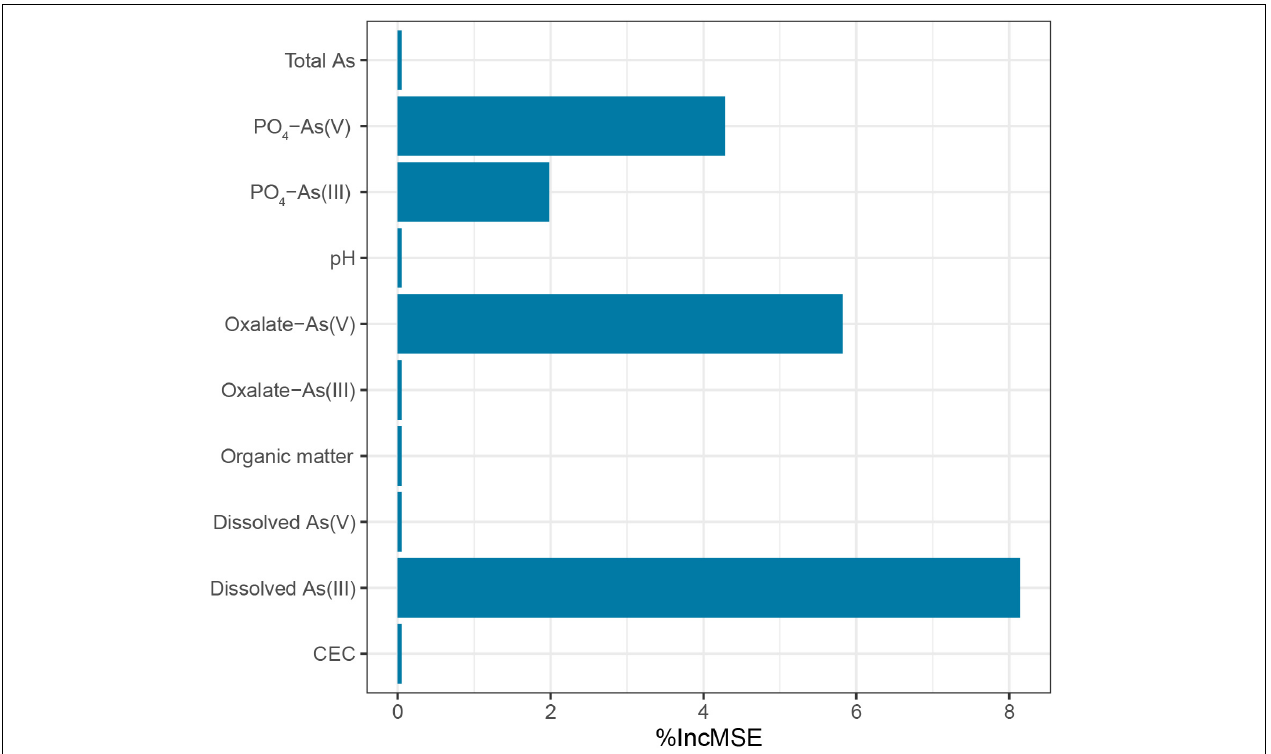
FIGURE 4 | Random forest (RF) predictions of the most influential environmental parameters on the Chao1 index of the aioA genes.